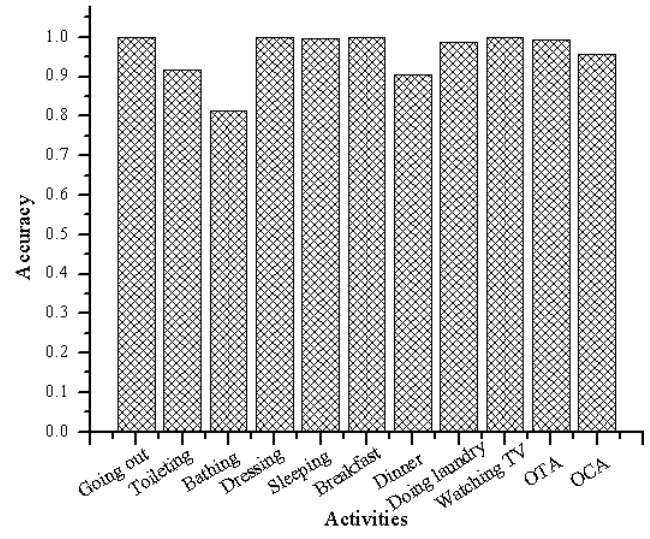
Figure 10. Algorithm’s (trained using the real-world data) accuracies per activity. The rightmost two bars compare the overall timeslice accuracy (OTA) and the overall class accuracy